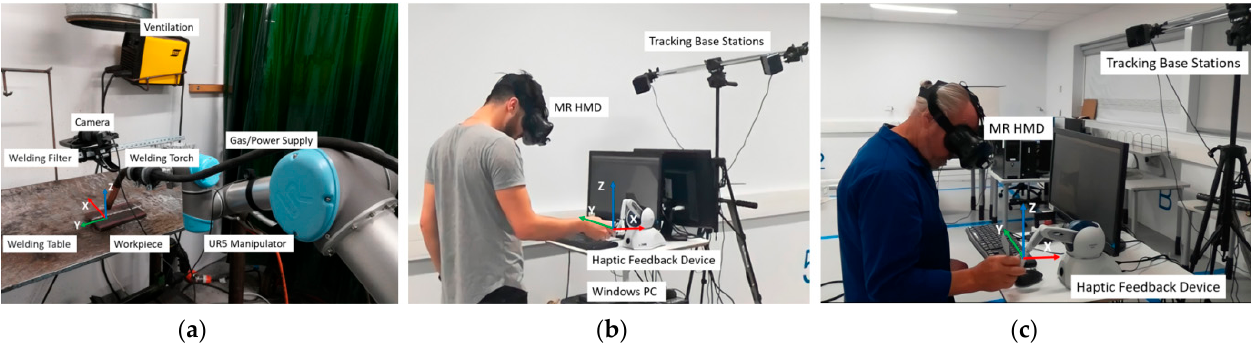
Figure 3. The imitation-based and robot-assisted teleoperation of the GMAW process. ( a ) Telerobotic welding platform including the UR5 manipulator, welding torch, and the attached vision system; ( b ) a novice welder conducting immersive and intuitive robot-assisted welding with haptic guidance; ( c ) a professional welder performing remote-controlled robotic GMAW operation for comparison.